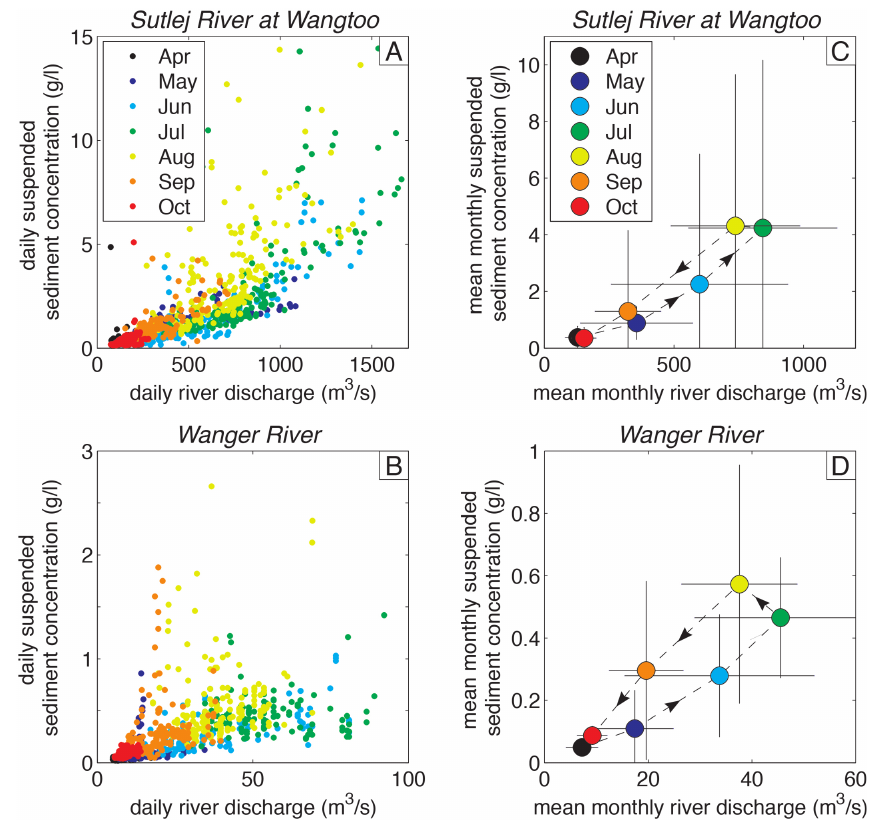
Fig. 9. Time series of daily river discharge and suspended sediment concentration data separated by month of the Sutlej River at Wangtoo (A) and the Wanger River (B) covering five and six years, respectively. Hysteresis loops of the mean monthly suspended sediment flux in the Sutlej River at Wangtoo (C) and the Wanger River (D) . The error bars represent the daily standard deviation ( ± 1 σ ) of the monthly river discharge and SSC mean,